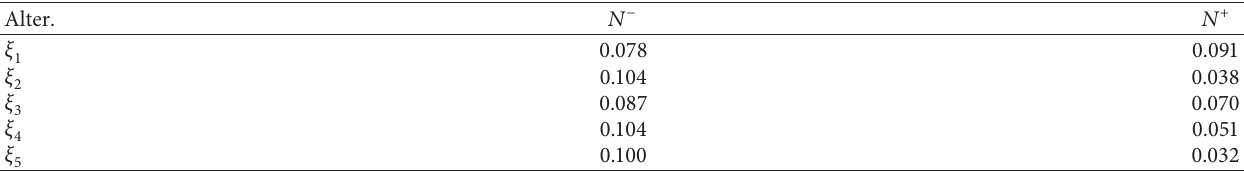
Table 29: Separation measures.